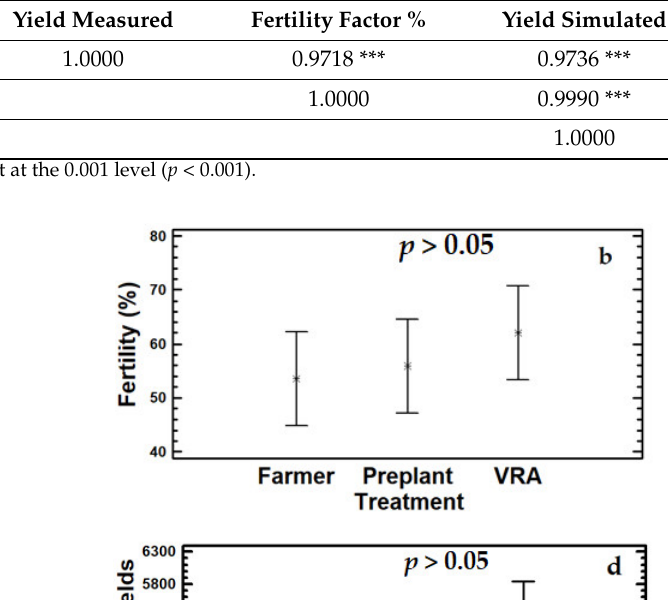
Table 10. Correlation coefficients matrix.